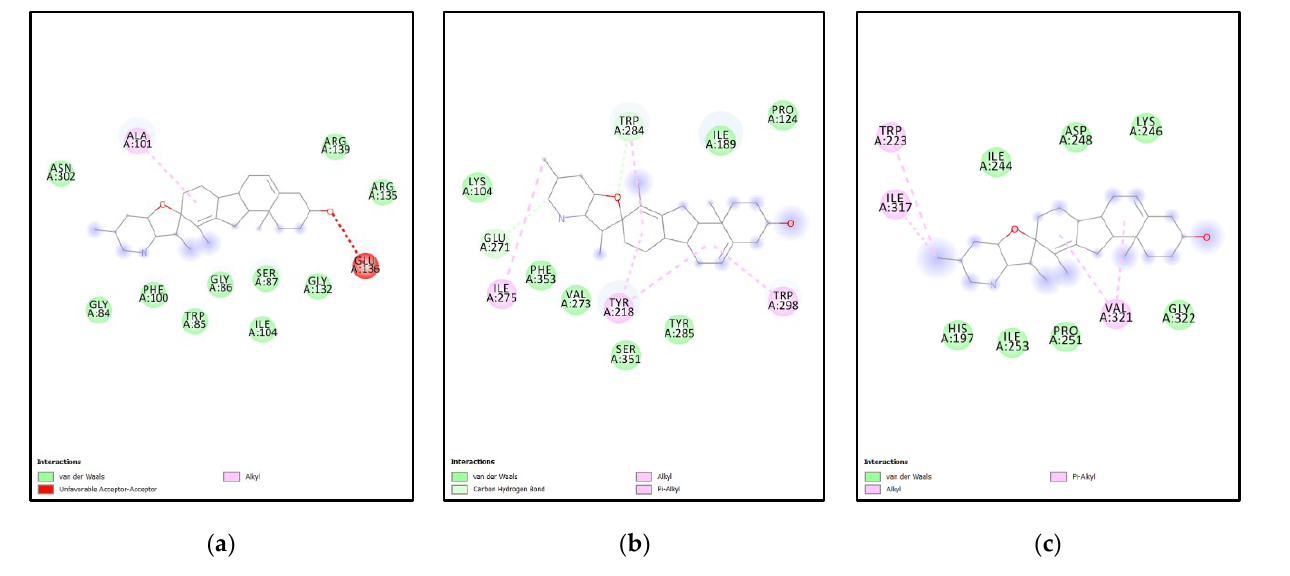
Figure 9. Ligplots showing amino acid residues involved in Cyclopamine-protein interactions ( a ) ERG6-Cyclopamine interacting amino acid residues ( b ) XP-Cyclopamine interacting amino acid residues ( c ) XM-Cyclopamine interacting amino acid residues.